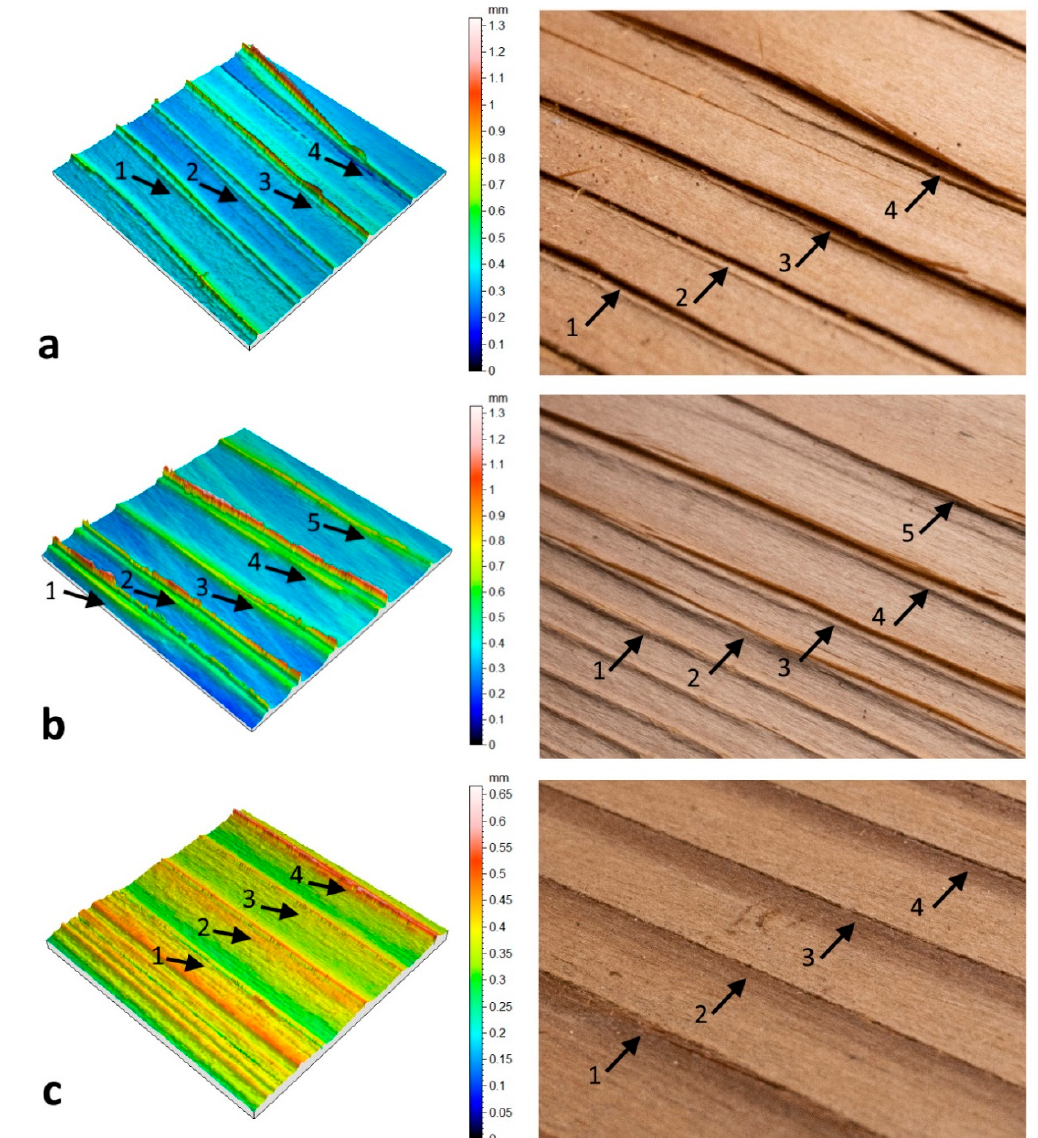
Figure 5. Confocal profilometry height maps showing shelling of growth rings in alkaline copper quaternary (ACQ) treated ( a ) western hemlock, ( b ) white spruce, and ( c ) Douglas fir deckboards with growth rings oriented pith-side-up and exposed to the weather for 18 months in Vancouver, BC, Canada.